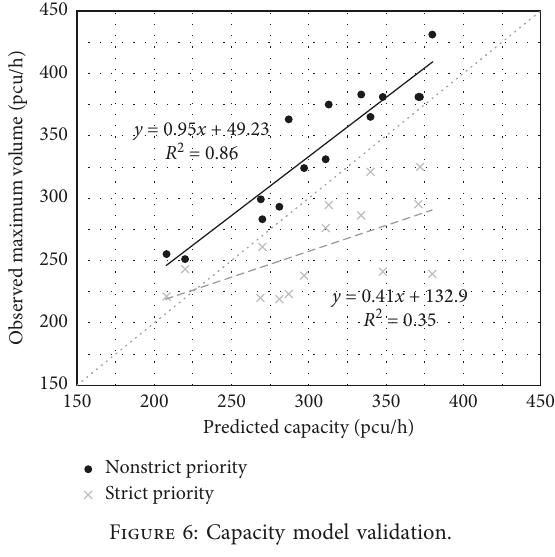
Figure 6: Capacity model